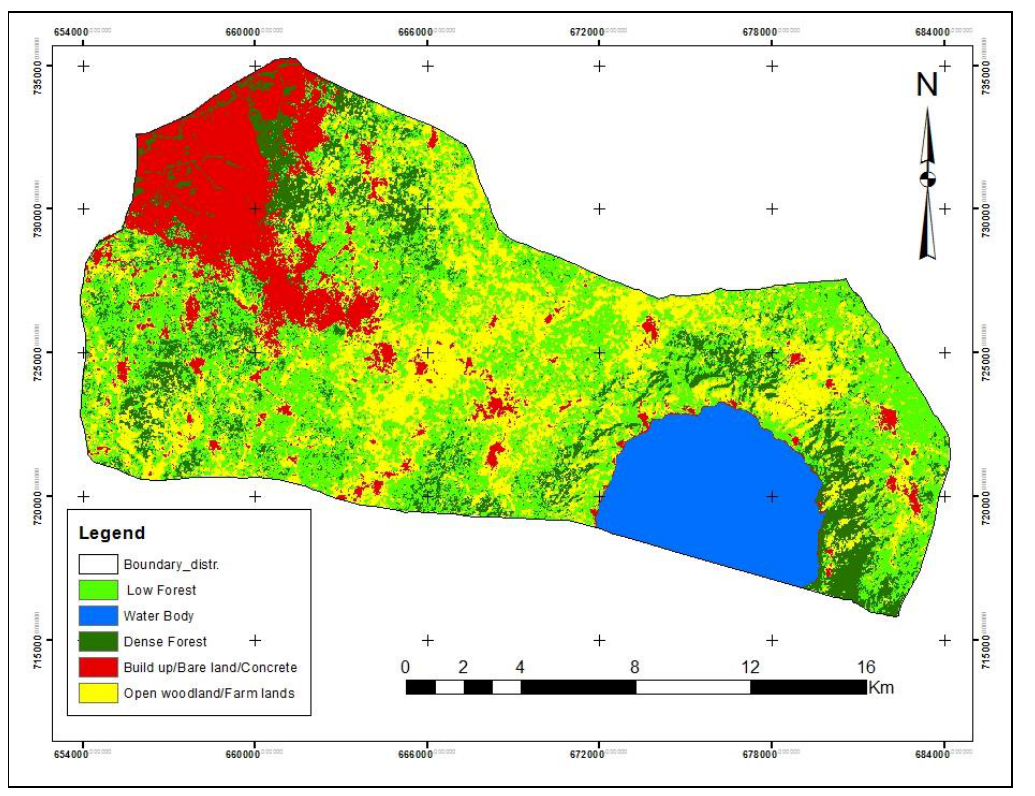
Figure 4. LULC Map of 2014 Landsat 8 OLI/TIS